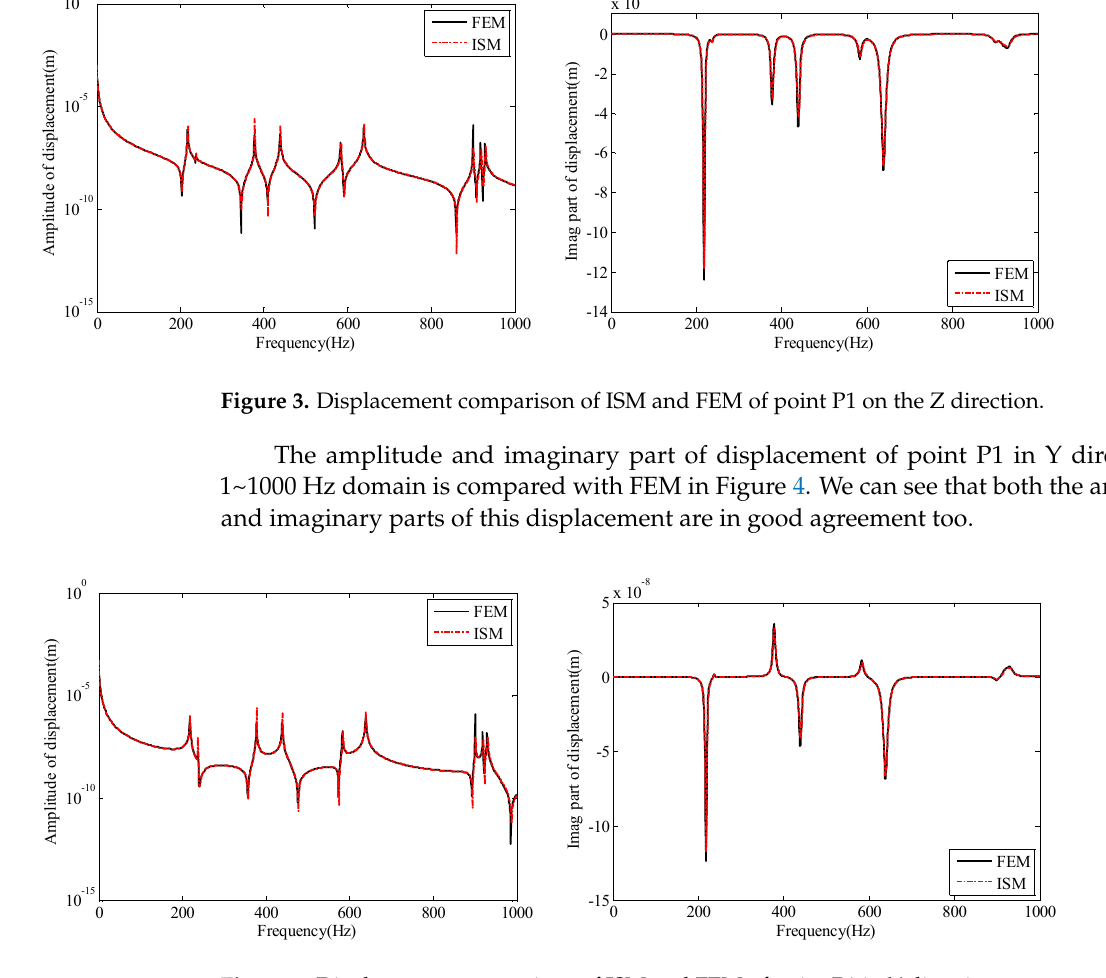
Figure 4. Displacement comparison of ISM and FEM of point P1 in Y direction. The vibration power flow is multiplied by the displacement and force, from the energy flow viewpoint in physics. Thus, the correctness of calculation forces also needs to be verified. Real and imaginary parts of the force on point P2 in the Z direction are compared with FEM in Figure 5. It can be seen that both real and imaginary parts of the force are in good agreement with FEM results. From the above comparison results, one can find that the impedance synthesis method (ISM) can be used for the truss structure and has high accuracy at mid and high frequency.